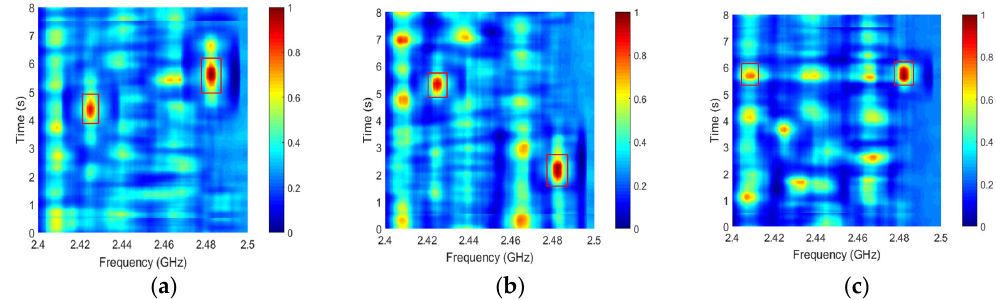
Figure 15. The results for the HOC method with two UAVs outdoors at distances of ( a ) 500 m, ( b ) 1500 m, and ( c ) 2500 m.